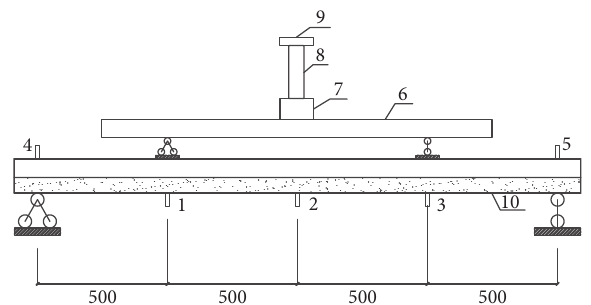
Figure 9: Plane arrangement of the loading device in the present test. (1–5) displacement meter; (6) distributive girder; (7) sensor; (8) jack; (9) counter-force rack; and (10) composite slab.